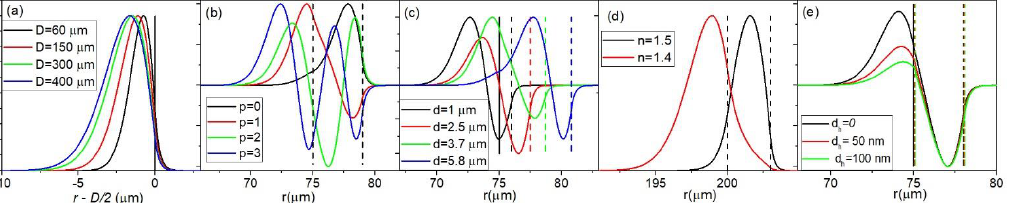
Figure 3. The normalized radial electric field profiles in respect to the distance from the center of the sphere r for: ( a ) d = 0, p = 0; ( b ) D = 150 μm, d = 4 μm; ( c ) D = 150 μm; p = 1; ( d ) D = 400 μm; d = 3 μm; p = 0; ( e ) D = 150 μm, d = 3 um, p = 1, n h = 1.9. The vertical lies correspond to the interfaces between the n s , n h , n c and n 0 layer.